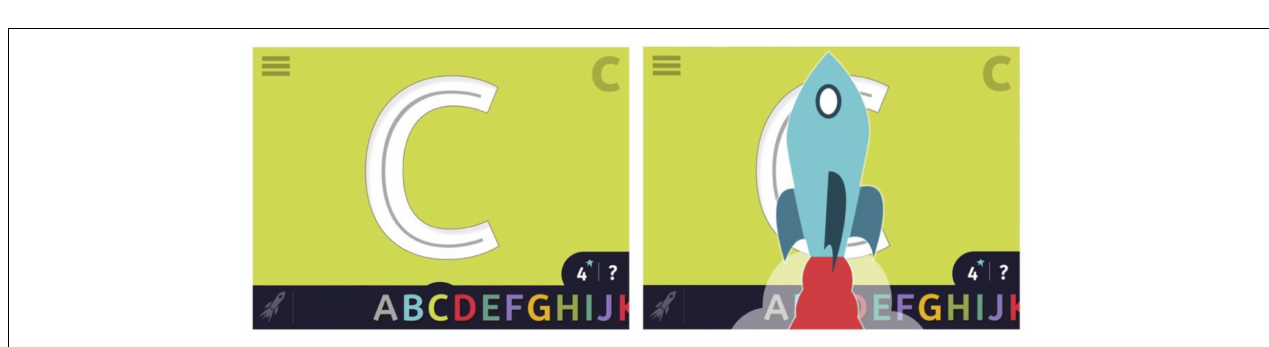
FIGURE 11 | The new interface design with a new counter feature in the bottom right corner of the interface (left) and a rocket animation that states “good job” during blast off (right) . Children can press the question mark in the lower right-hand corner for “help,” which will then launch the trace hint animation (see Figure 5 ). Alternately, if there is a delay in game play, help appears